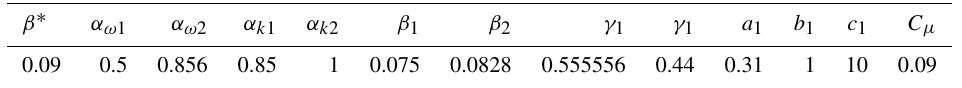
Table A2. Coefficients of the k − ω turbulence model.